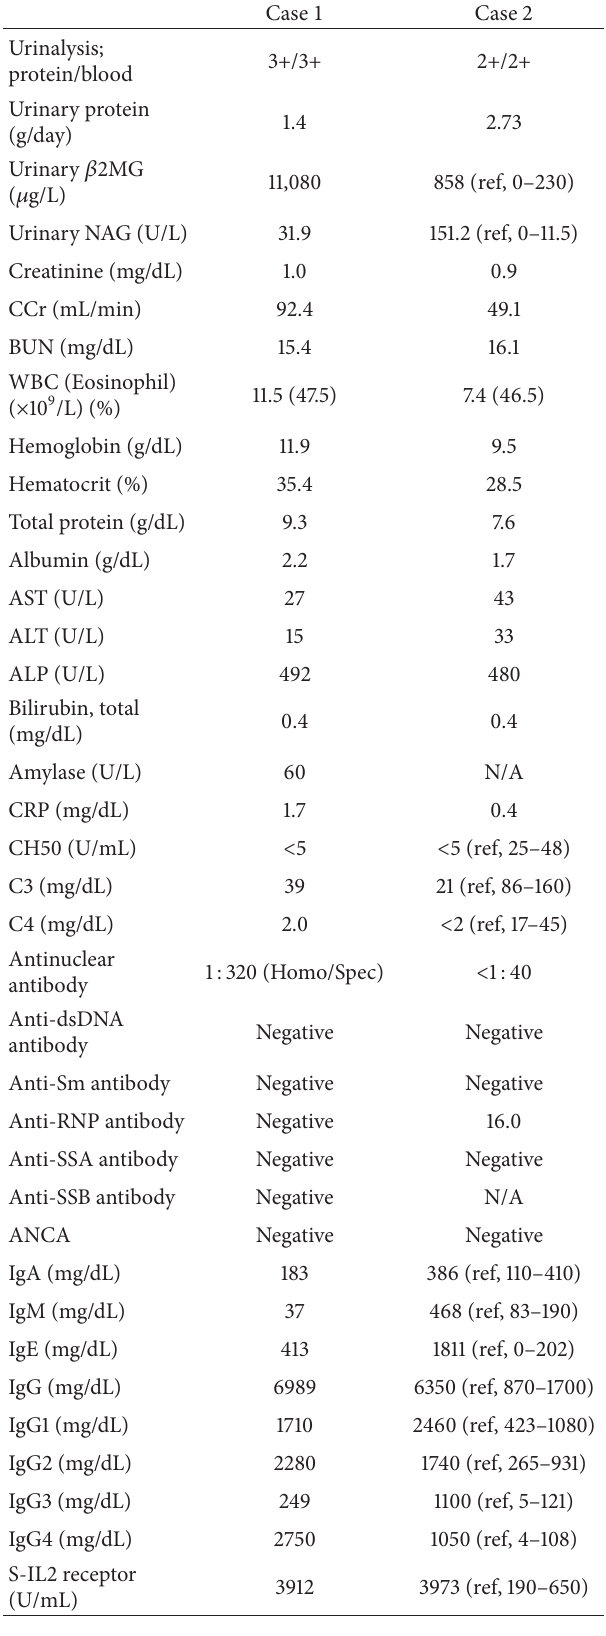
Table 1: Laboratory findings. Case 1 Case 2 SPEP Normal Normal Cryoglobulin Negative